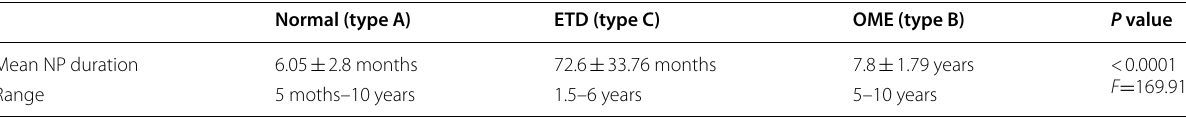
NP Nasal polyposis, ETD Eustachian tube dysfunction, OME Otitis media with effusion, F One‑way ANOVA